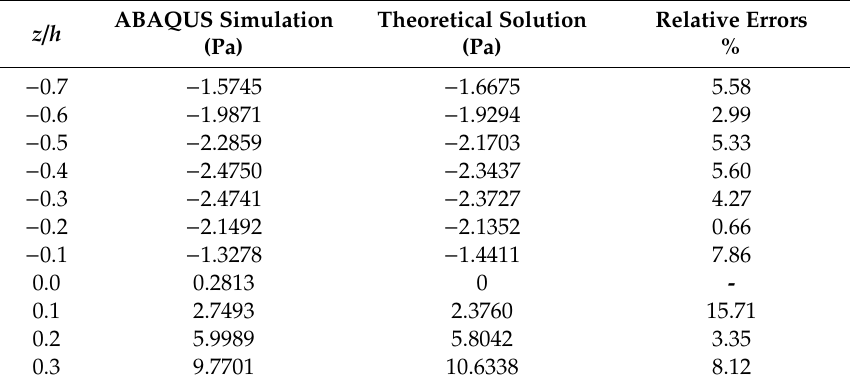
Table 2. Relative errors of two solutions of σ x ( x = 0.25 l ).